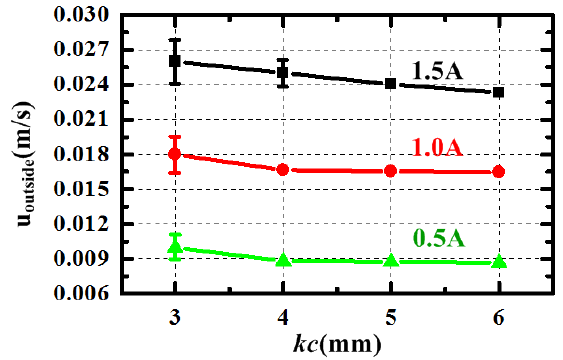
Figure 6. The generated velocity u outside changing with different central channel’s thickness k c at energized current 0.5, 1.0 and 1.5 A.